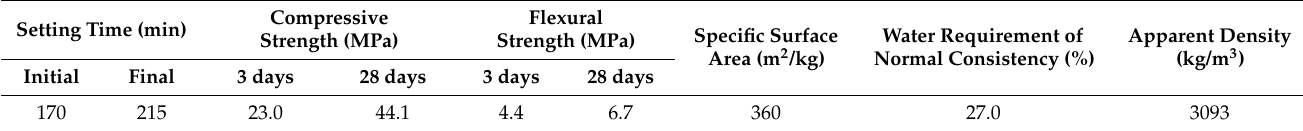
Table 1. This met the specifications of China code GB175 [25]. Table 1. Physical and mechanical properties of cement.